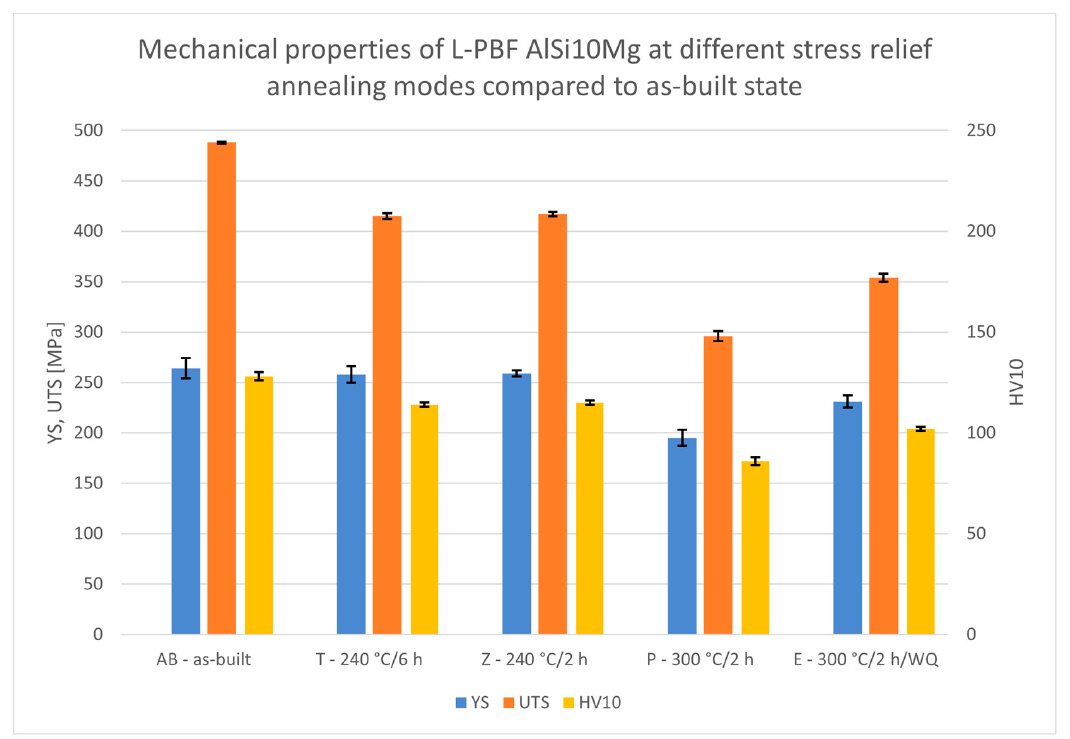
Figure 6. Graph summarizing mechanical properties of as-built and heat-treated L-PBF ASi10Mg within one build cycle.